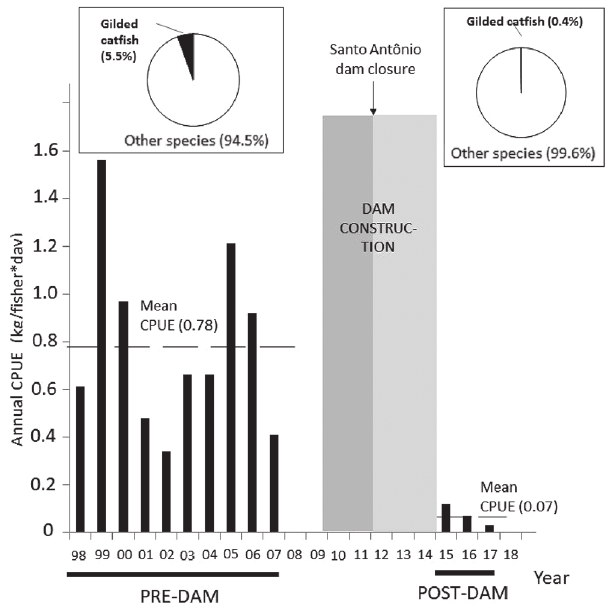
Fig. 2. Annual catch per unit effort (CPUE) of Brachyplatystoma rousseauxii before and after dam closure. The horizontal dotted line before dam closure depicts the mean annual CPUE between 1998 and 2007. The inserted diagrams show the relative contribution of gilded catfish to river catch before and after closure.